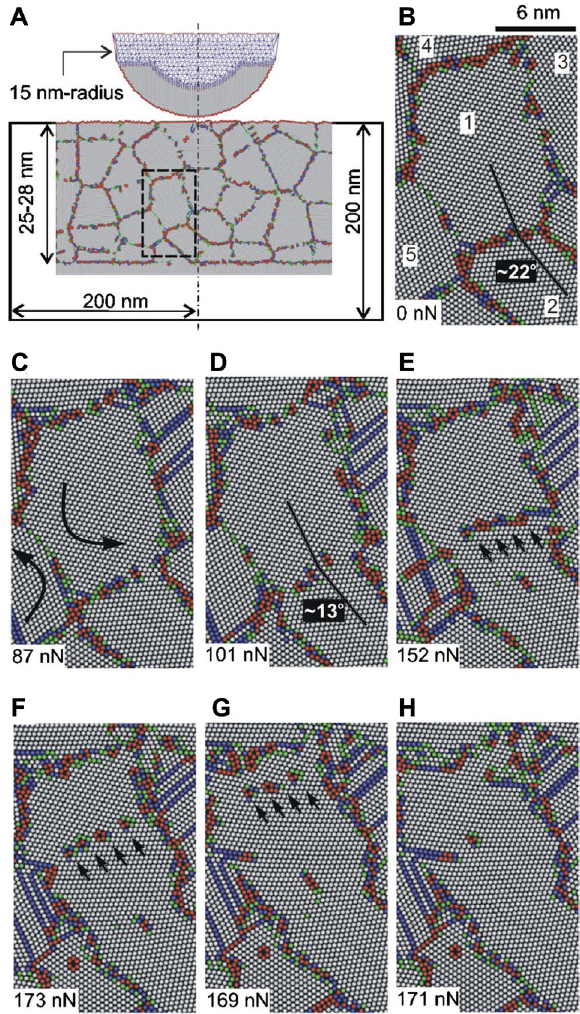
Figure 3 Nanoscale rotational deformation in nanocrystalline